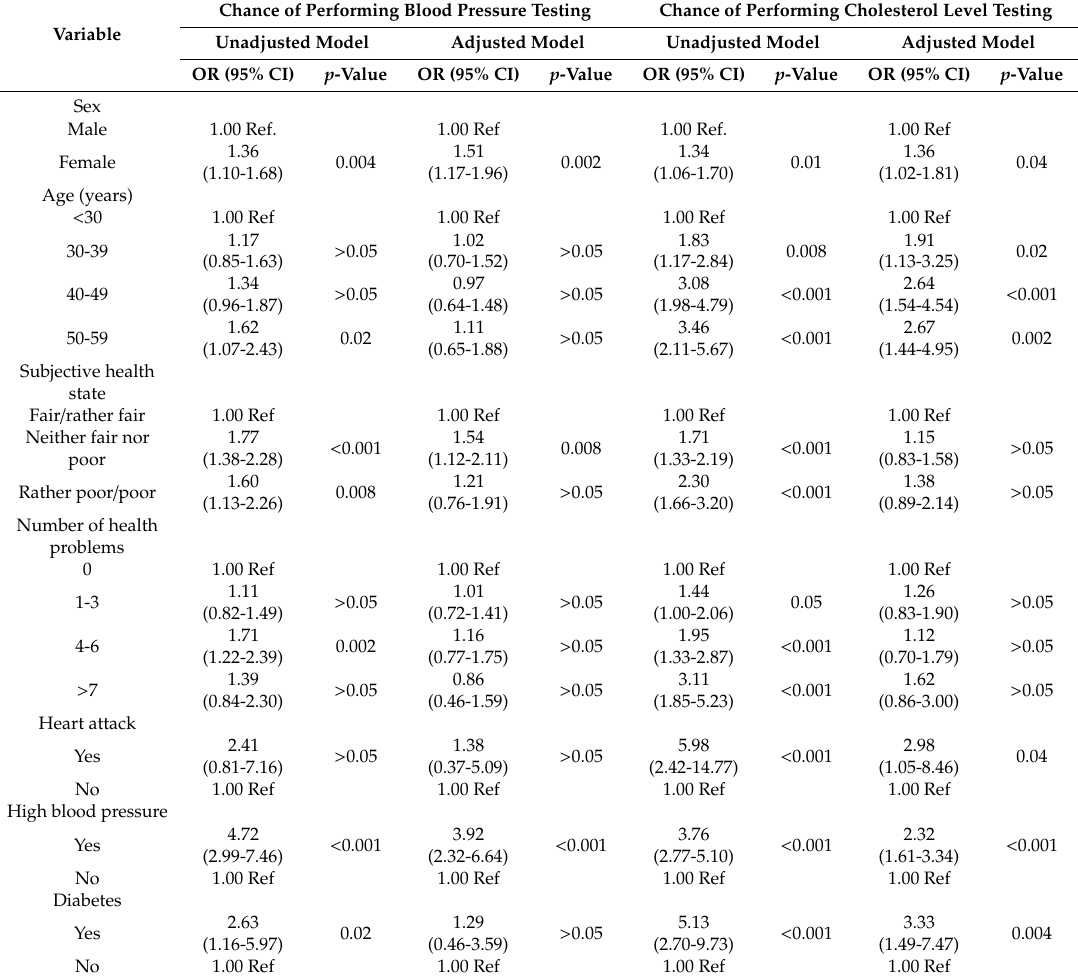
Table 2. Chance of performing blood pressure and cholesterol level